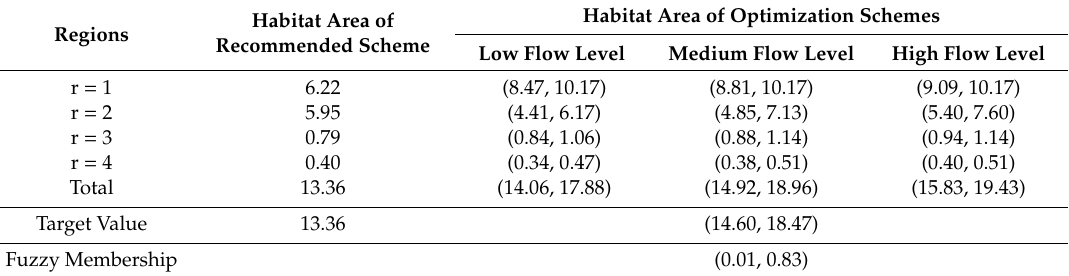
Table 3. Suitable habitat area for rare migratory water birds recovered prior to and after the optimization of the ecological water supplement schemes (10 3